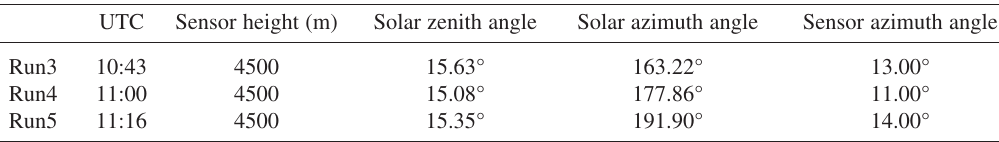
Table II. For each run the UTC, the solar zenith and sensor azimuth angles are shown. UTC Sensor height (m) Solar zenith angle Solar azimuth angle Sensor azimuth